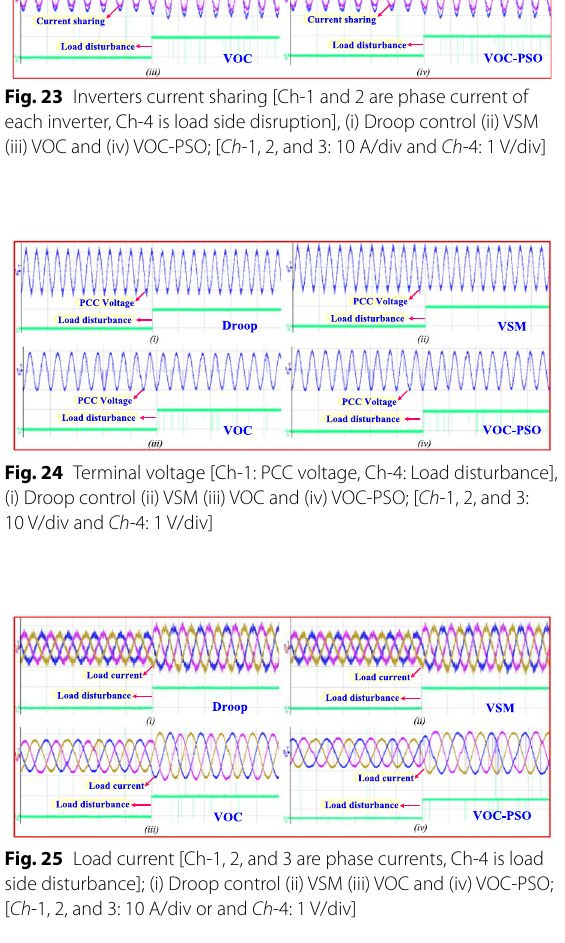
Fig. 27 Schematic of hardware model